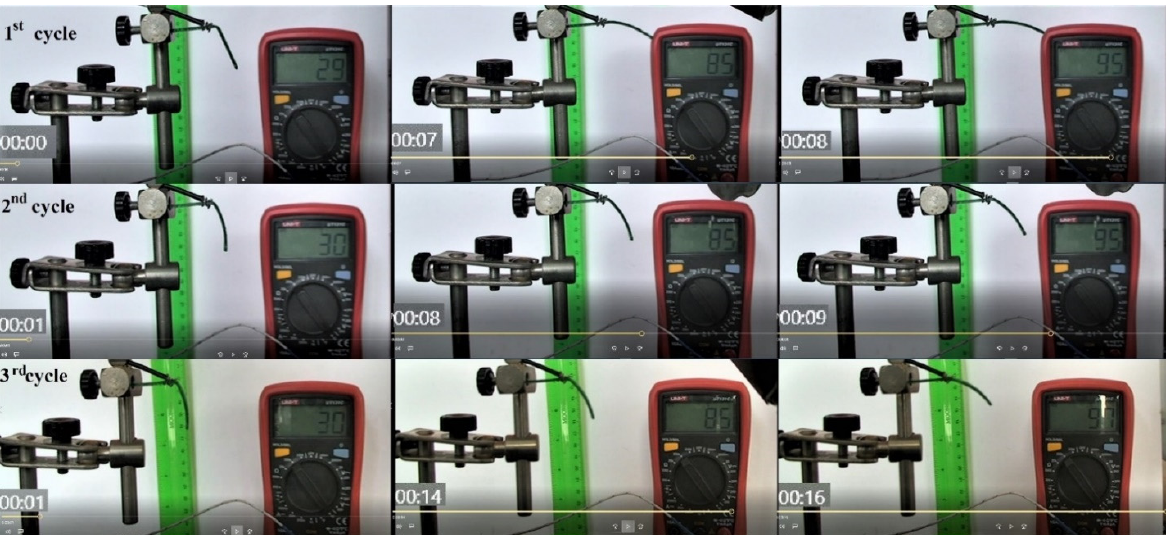
Figure 4. Typical images recorded during the occurrence of free-recovery SME at a 3D printed R-PET specimen during three consecutive heating-cooling-bending cycles. Time duration details (s).